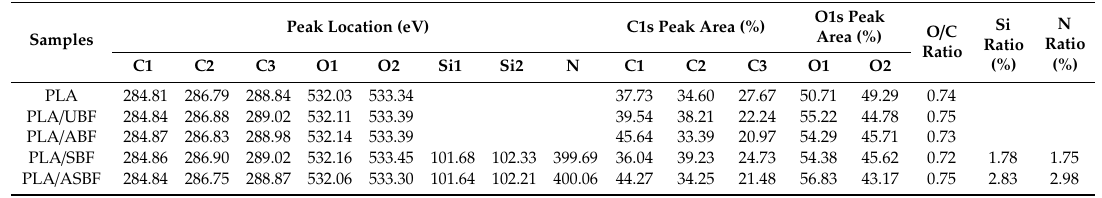
Table 7. XPS data of PLA / BF composites modified by various methods.